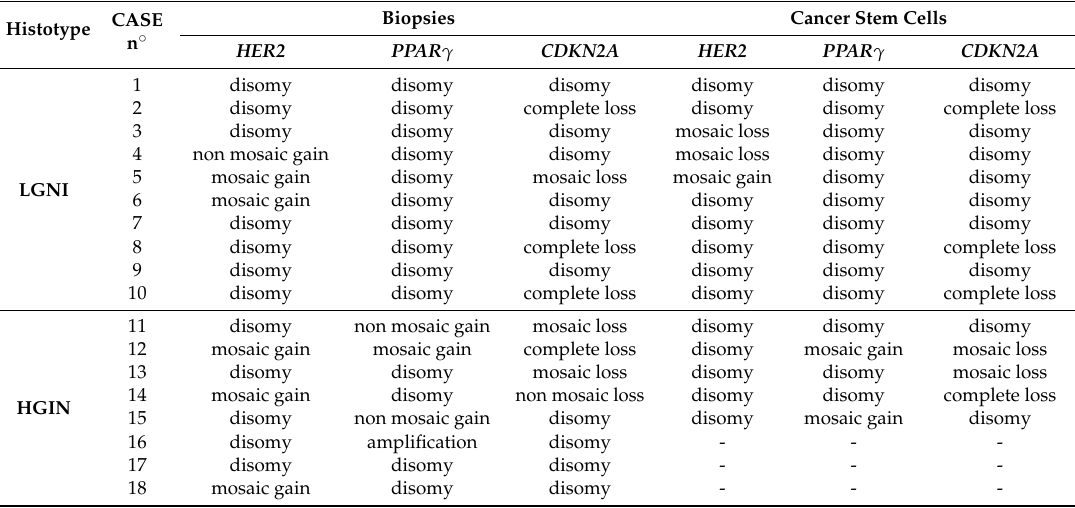
Table 3. Array-CGH results. Comparison between biopsies and cancer stem